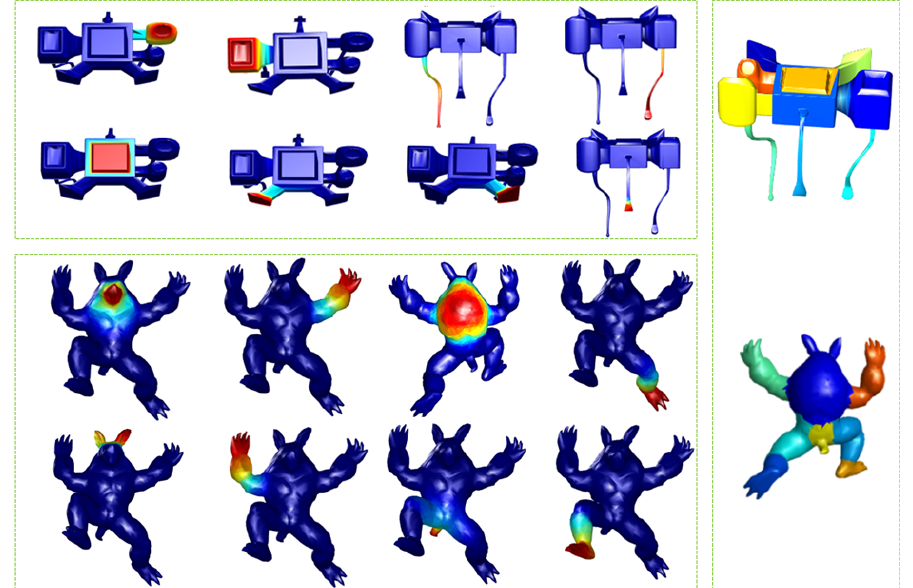
Figure 7. Application of our framework to segmentation on the tele-alien and armadillo models (with the left part demonstrates the feature bases obtained).